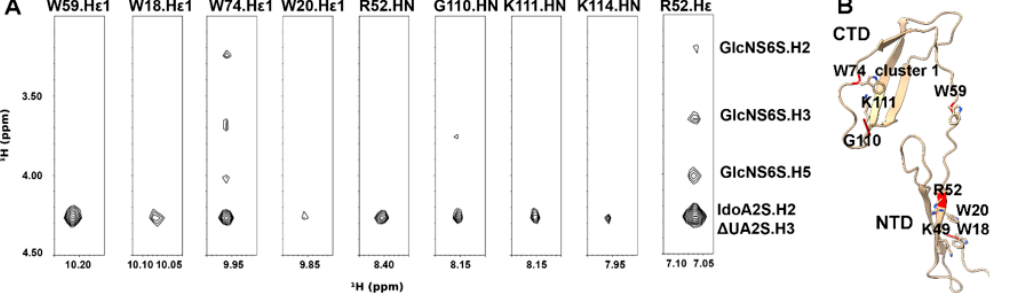
Figure 2. Intermolecular NOE between PTN and DP6-C seen in the 15 N-edited NOESYHSQC of 0.3 mM 1 H back-exchanged 2 H, 15 N-labeled PTN with 0.9 mM DP6-C. ( A ) Strips from the NOESYHSQC spectrum showing intermolecular contacts between PTN and DP6-C. ( B ) Ribbon representation of PTN with the residues involved in intermolecular contacts colored in red.